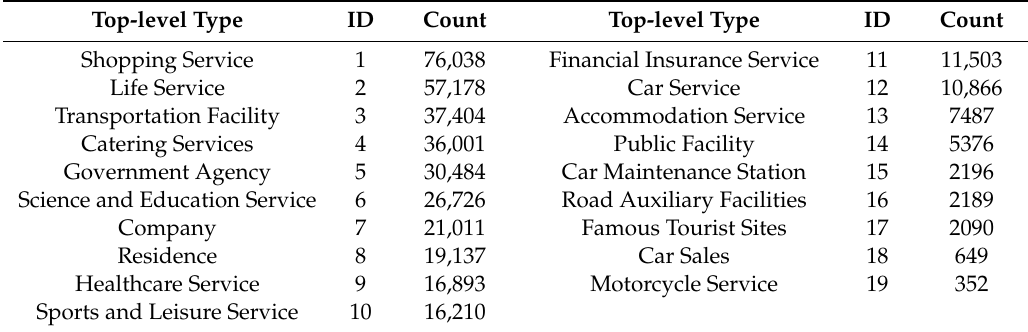
Table 3. Type and count of top-level POI